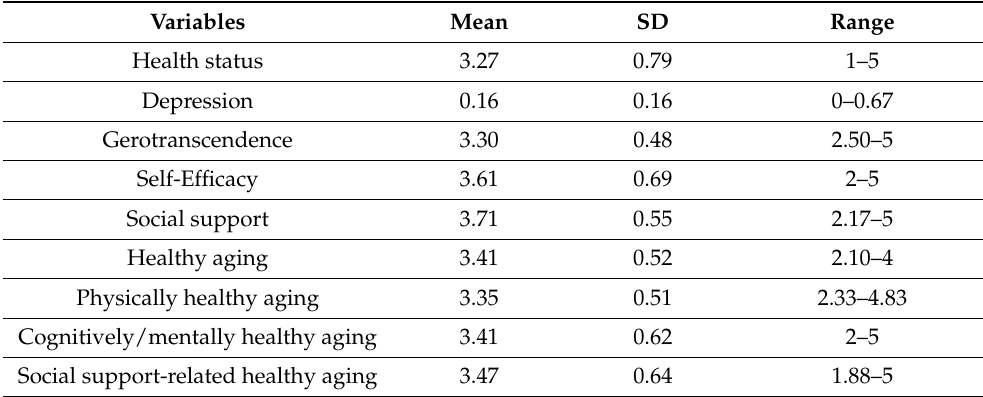
Table 2. Degree of health status, depression, gerotranscendence, self-efficacy, social support, and healthy aging of